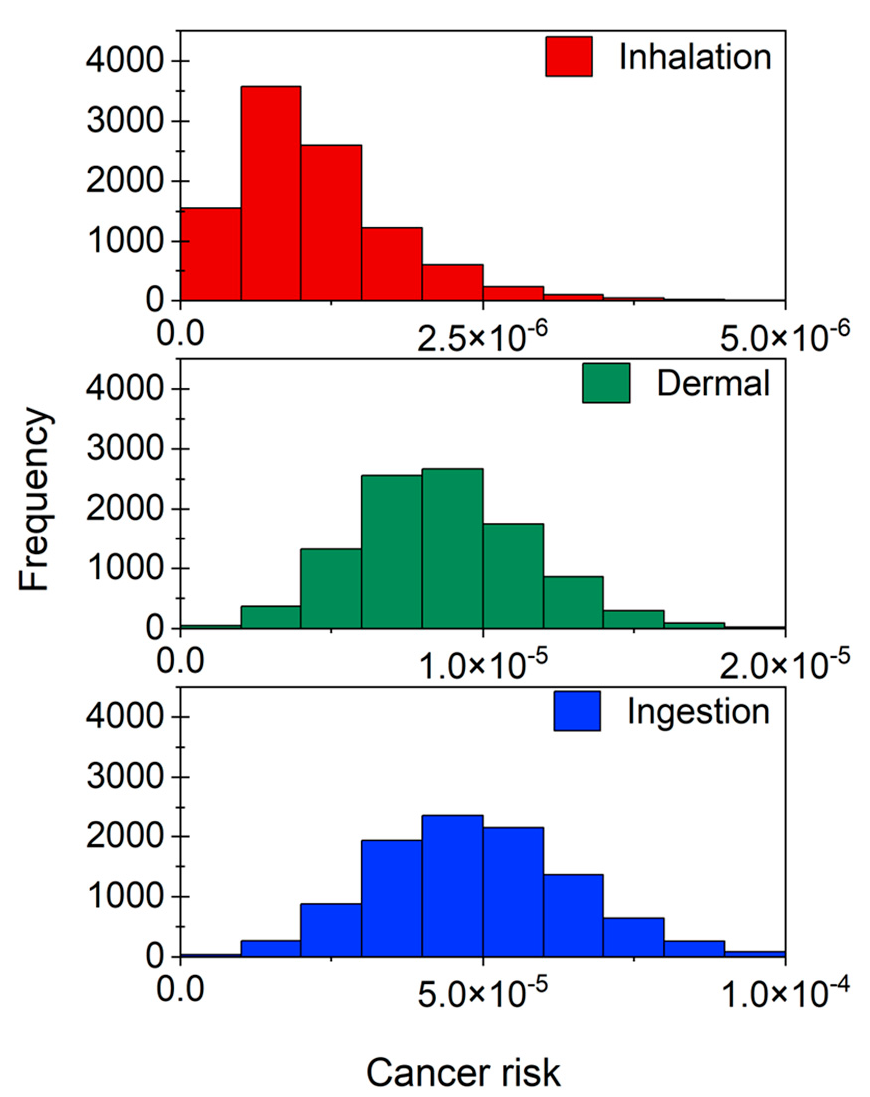
Figure 6. Frequency distribution of total cancer risk through ingestion, dermal contact, and inhalation routes for private shower rooms.